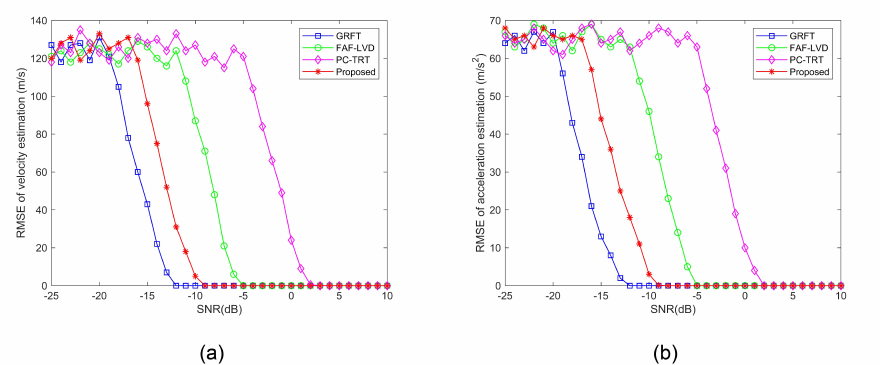
Figure 12. Parameter estimation performance of different methods. ( a ) RMSE of velocity estimation. ( b ) RMSE of acceleration